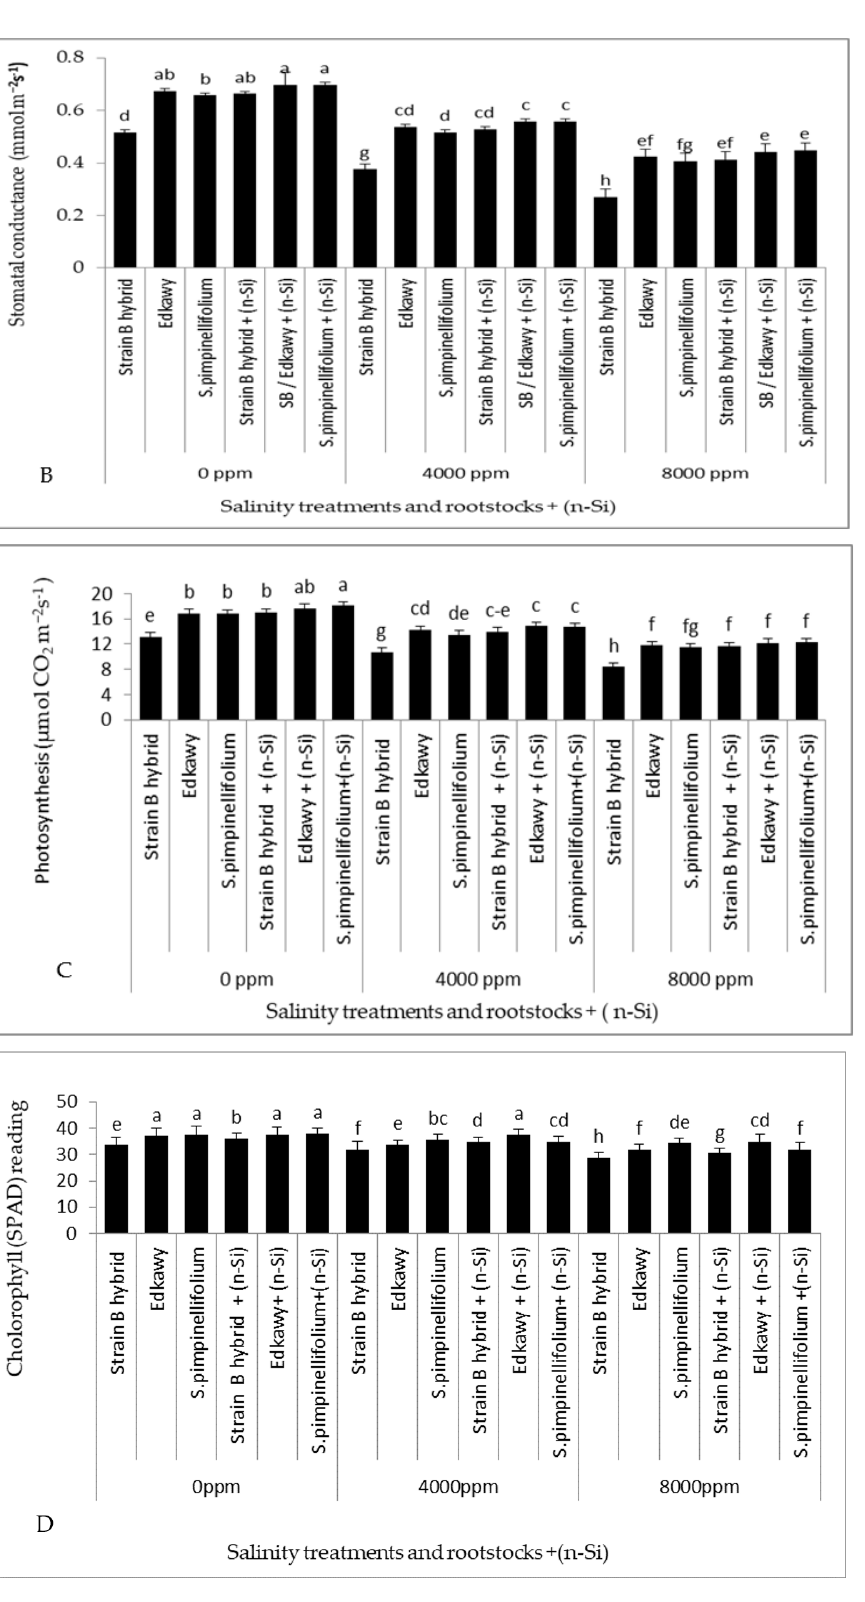
Figure 3. Effects of water salinity levels, rootstocks, foliar spray with (n-Si), and their interactions on ( A ) transpiration rates, ( B ) stomatal conductance, ( C ) photosynthesis and ( D ) SPAD readings. Vertical bars represent standard errors of the mean; in each bar, values followed by different letters differ significantly at p = 0.05 according to the LSD